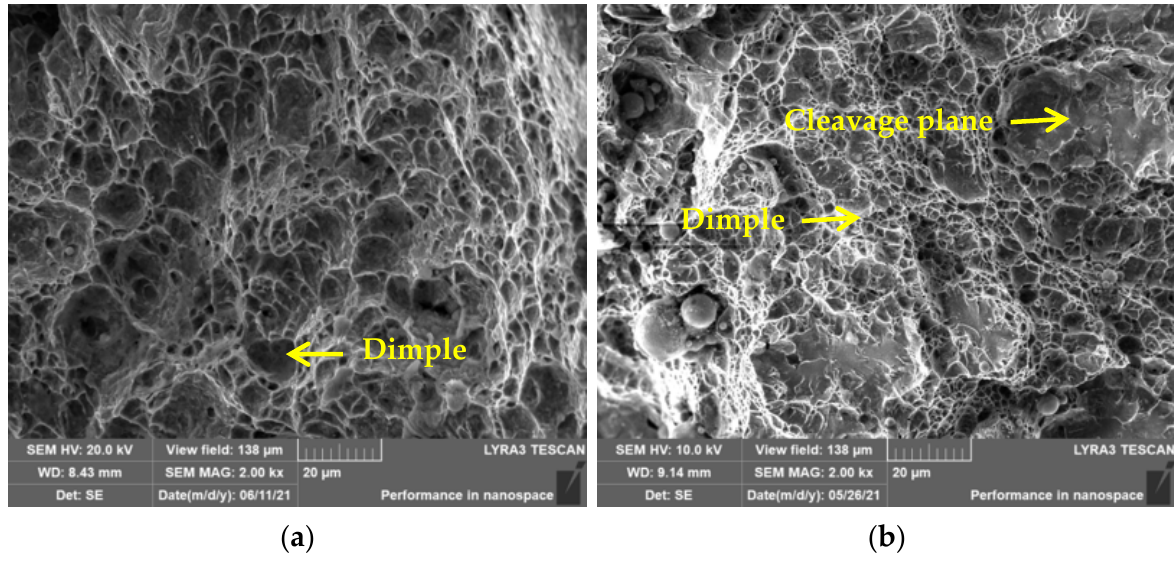
Figure 6. Morphology of the impact fracture of real weld HAZ: ( a ) 0 V; ( b ) 10 V.